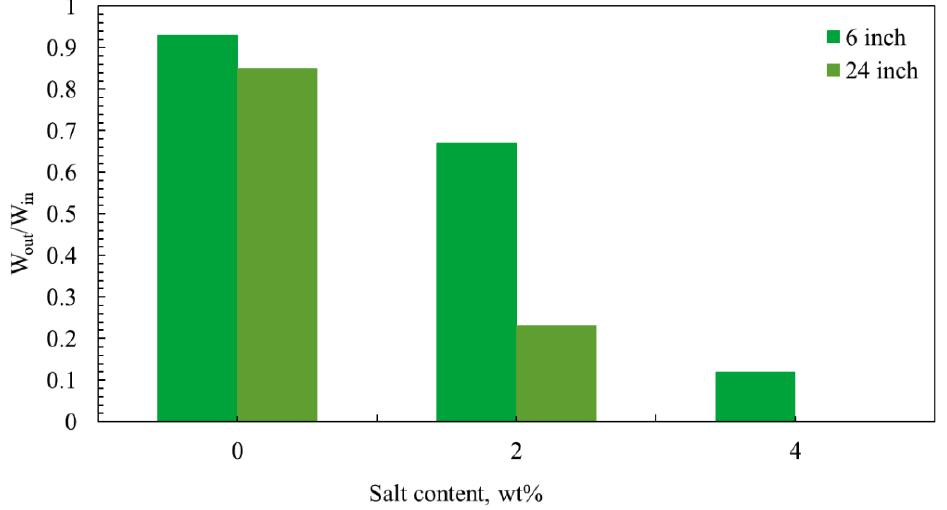
Figure 4. Salt-induced nanoparticle agglomeration and retention in a fabricated porous media (Test temperature: 40 °C; flow rate of injection: 1 mL/min; concentration: 0.5 wt%).